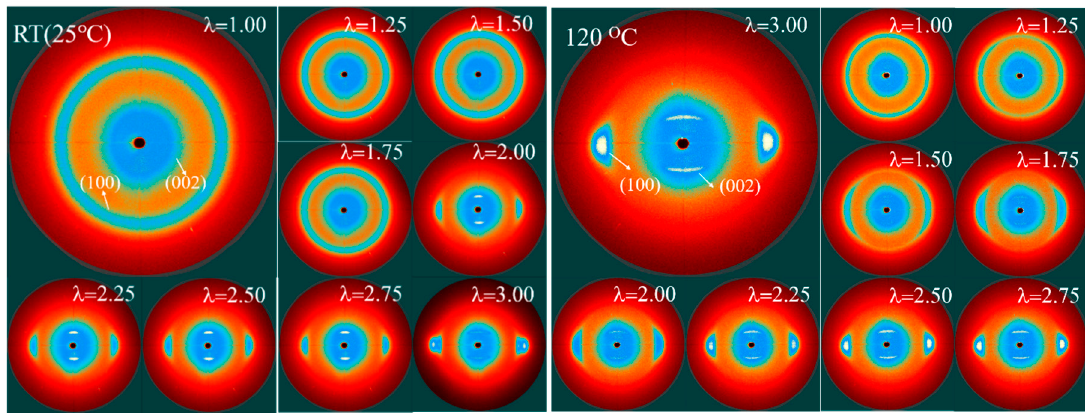
Figure 3. The 2D wide-angle X-ray diffractometer (WAXD) patterns of γ -PA1010 at RT and 120 °C.